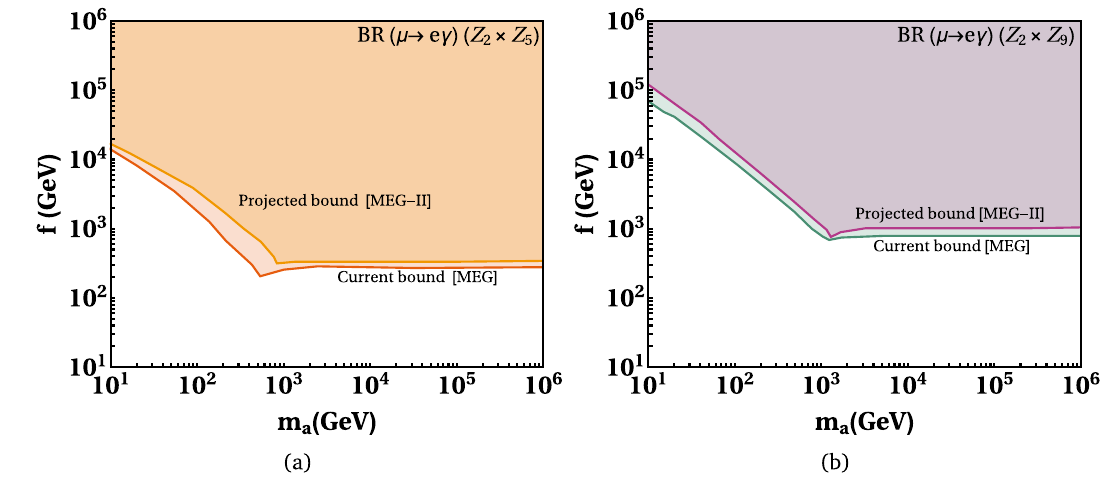
( Z × Z ) model with λ χ = 2 in the m − f plane. The same bounds a 2 5 for the non-minimal ( Z 2 × Z 9 ) model are shown in the right panel with green and magenta coloured curves,